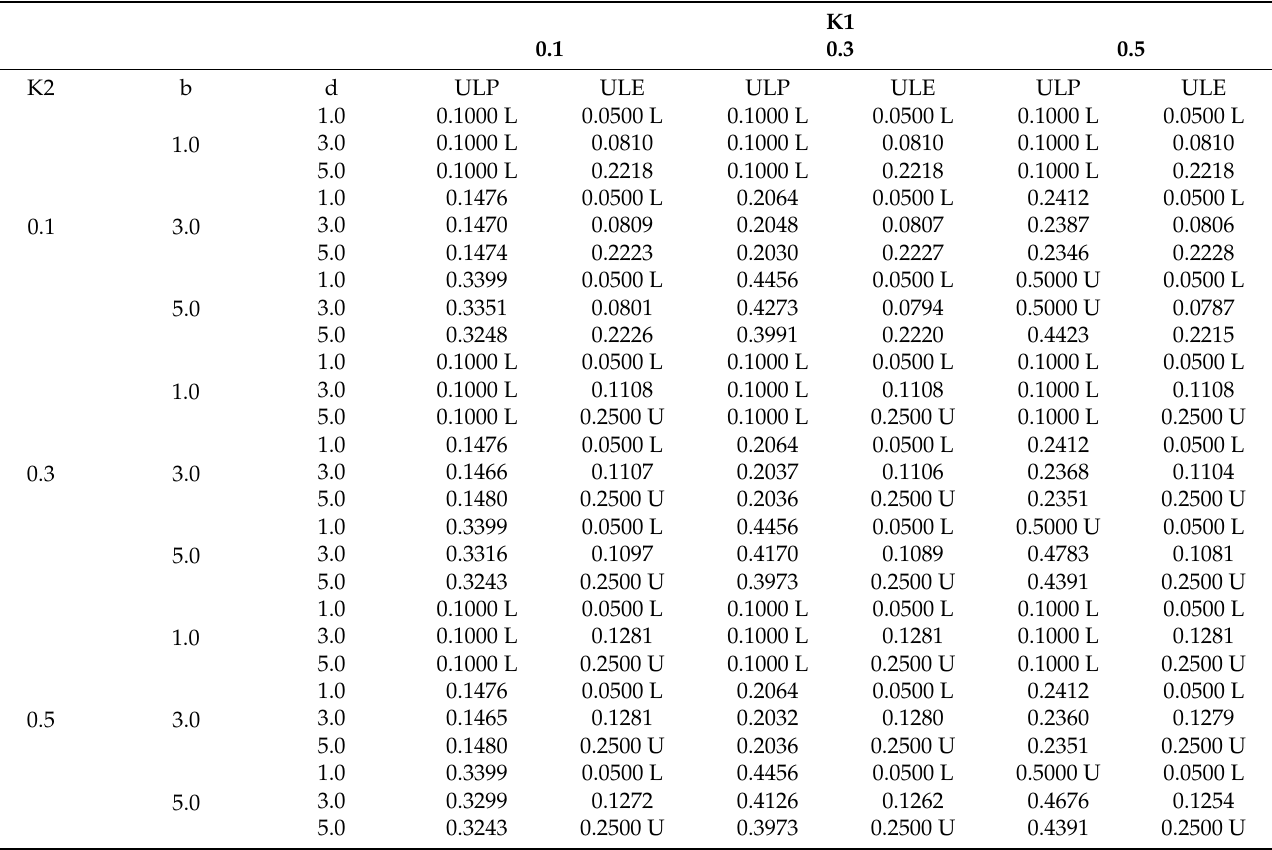
Table 17. Grid Analysis for Optimal ULP and ULE—L4